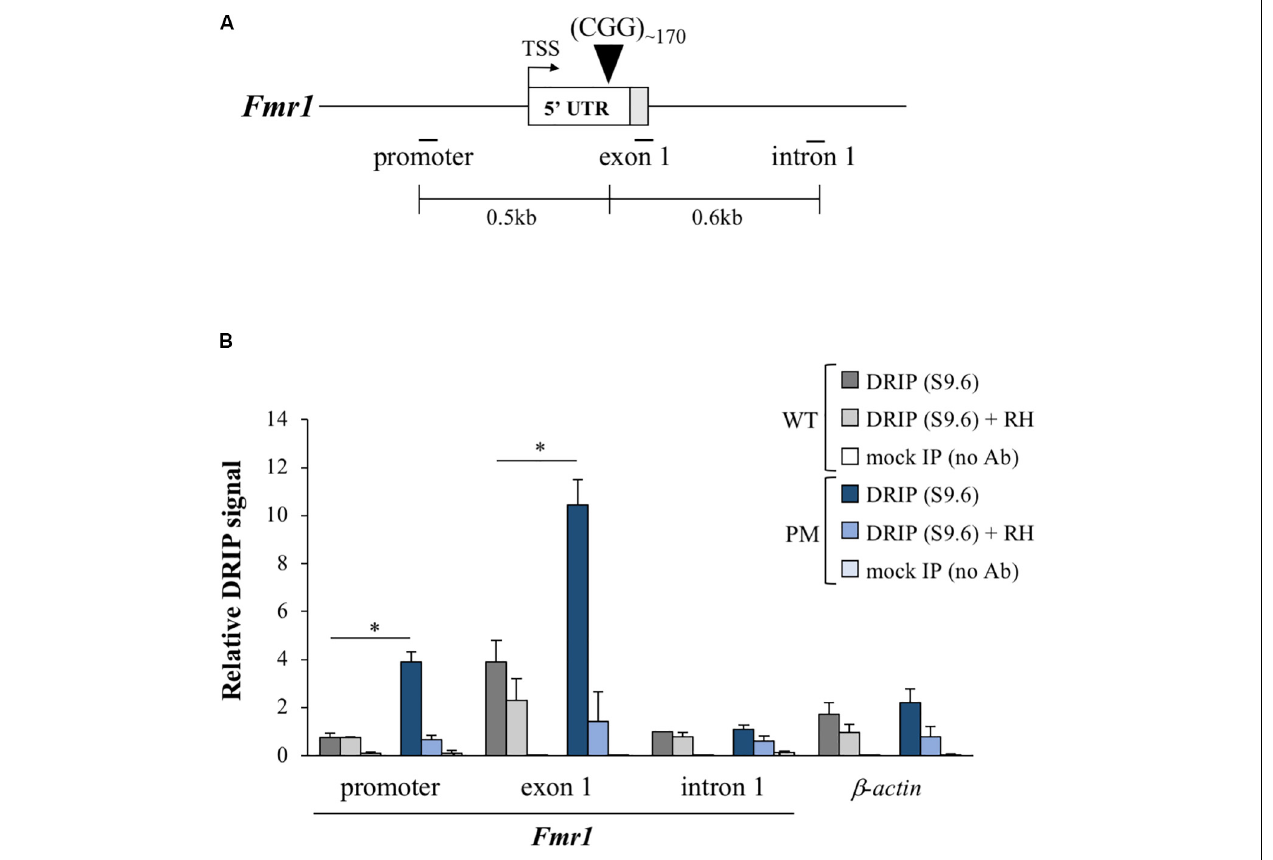
FIGURE 6 | R-loop formation in the FX PM mESCs. (A) Diagram of the Fmr1 gene 5 (cid:48) region showing the relative positions of the qPCR amplicons used in DNA:RNA immunoprecipitation (DRIP) experiments. White box is exon 1 5 (cid:48) UTR and gray the coding sequence (CDS). TSS is the transcriptional start site. Numbers indicate the distances from the CGG repeats. (B) R-loop enrichment in the Fmr1 locus and β - actin (positive control gene; Skourti-Stathaki et al., 2019) was determined by DRIP analysis in 3 WT and 3 PM lines cultured at 3% O 2 . Pretreatment with RNase H (RH) was used as a control for the pull down. Values are relative to intron 1 in WT cells and displayed as mean ± SEM. * p <